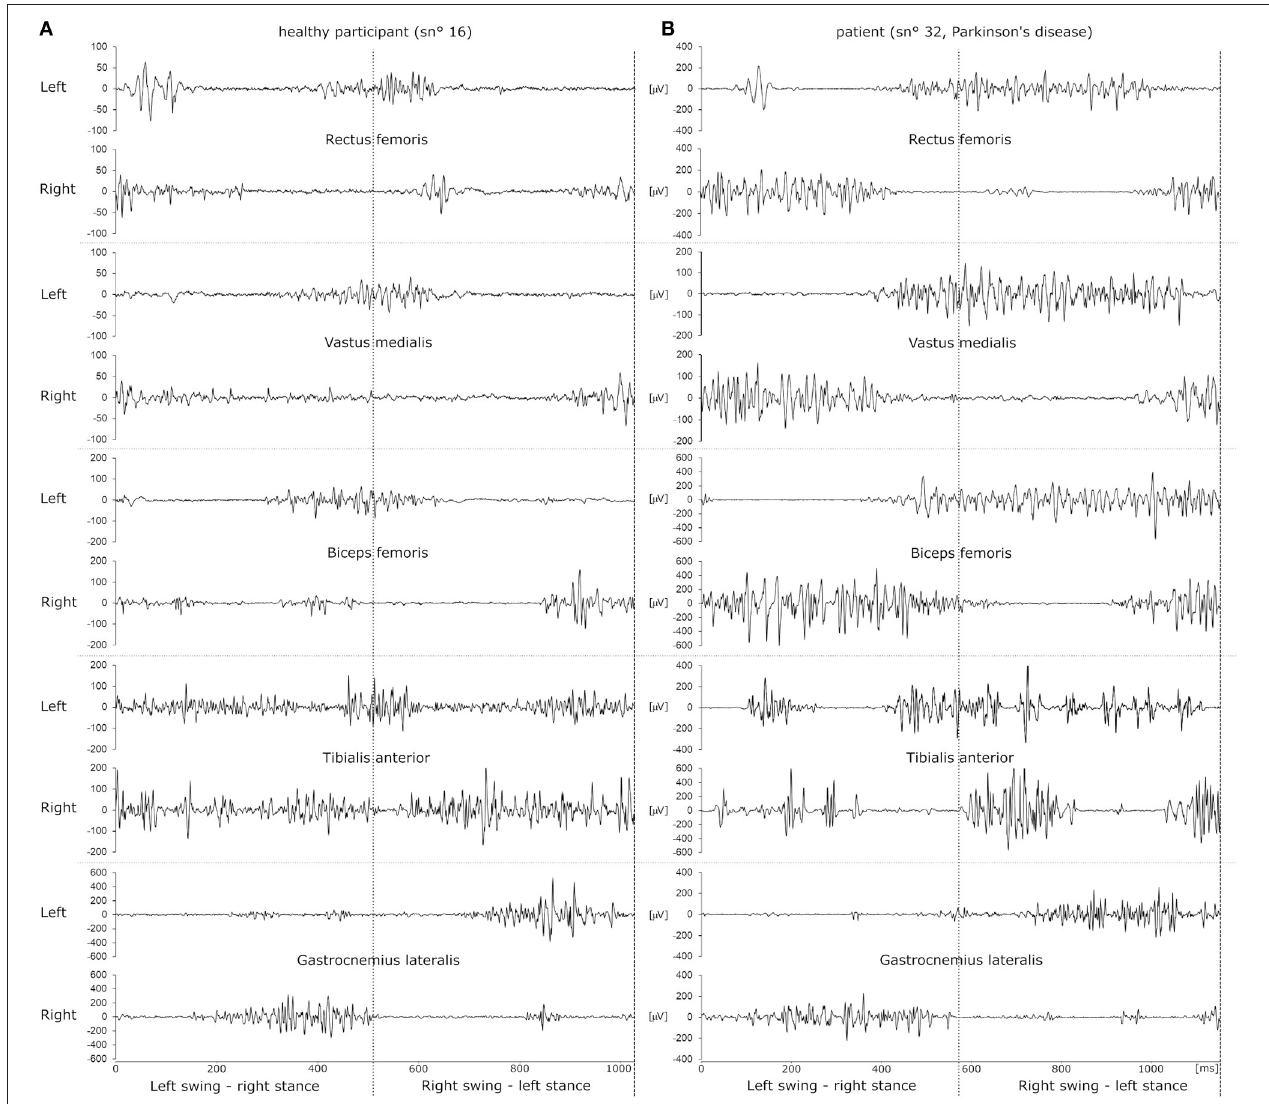
FIGURE 1 | Example raw EMG datasets of a single gait cycle of a healthy participant (A) and a patient with Parkinson’s disease (B) . EMG traces recorded from left and right leg muscles are depicted as pairs above one another. The dotted vertical line in the middle of the panels illustrates the time of ground contact with the left foot. Ground contact with the right foot happens at 0ms and at the end of the dataset, indicated by a dashed line. Thus, the left leg transitions into swing phase in the first half of the dataset while the right foot is placed on the ground and vice versa for the second half of the